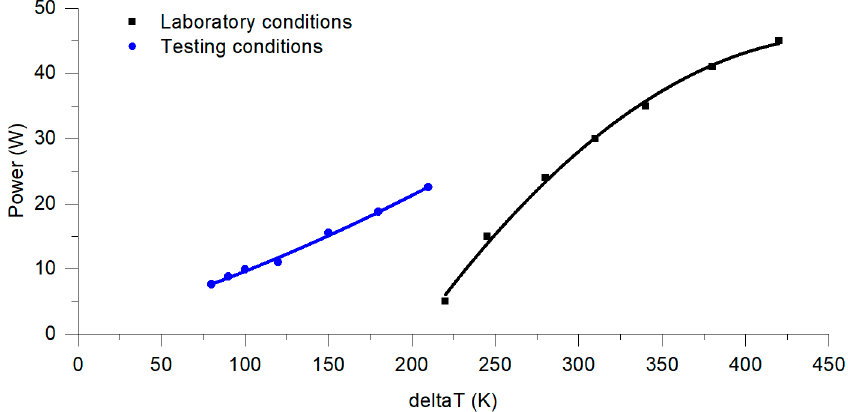
Figure 9. The comparison of TEG number 1 operating parameters in testing and laboratory conditions.